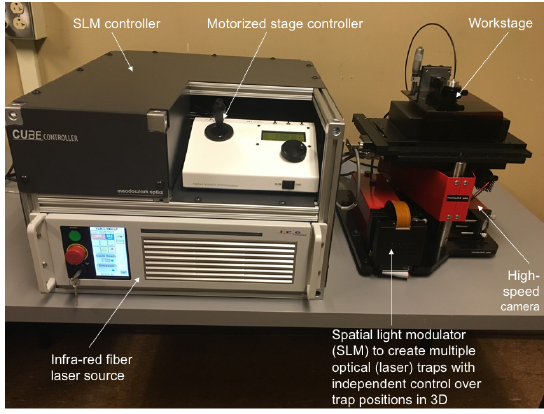
Figure 1. Holographic optical tweezers